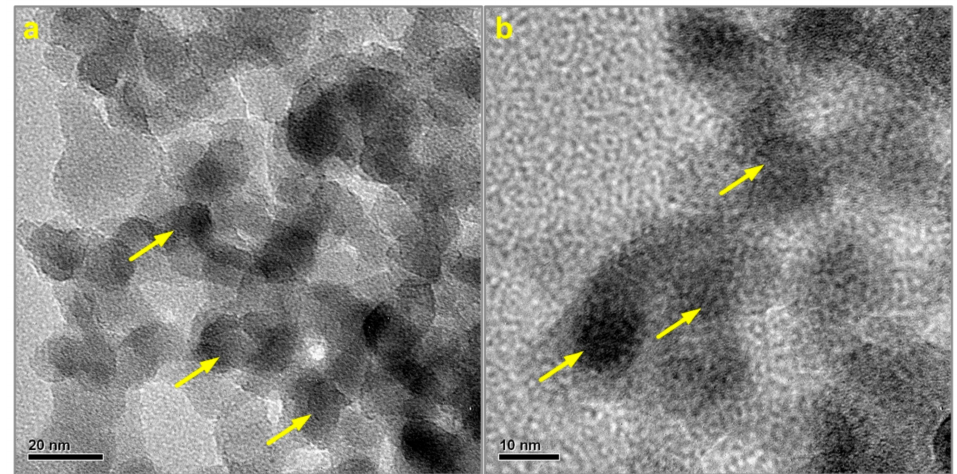
Figure 4. Transmission Electron Microscope (TEM) images of the SP&T nanocomposite indicating the amorphous phase of TiO 2 nanoparticles and showing homogeneity ( a ) and interconnectivity ( b ).